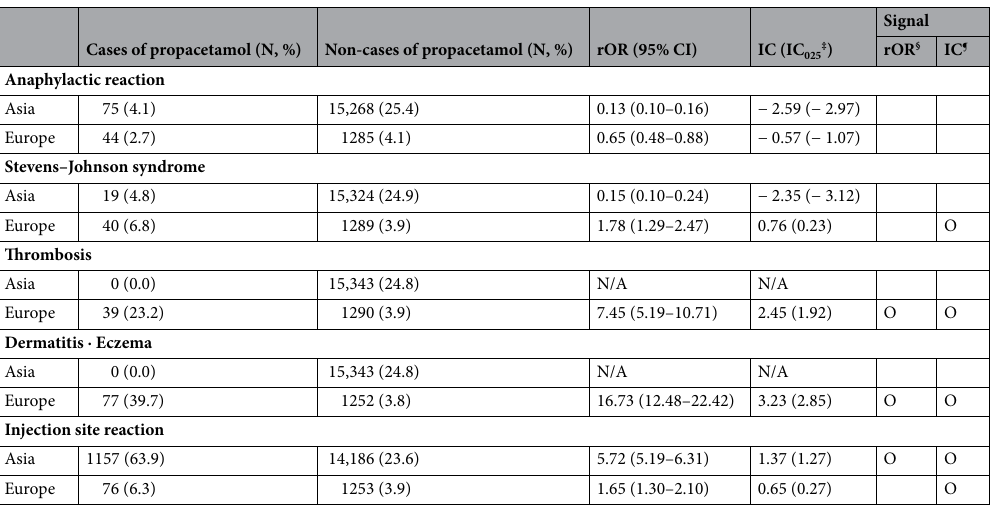
Table 3. Signal detection of propacetamol using disproportionality methods and empirical Bayesian geometric mean in WHO-UMC VigiBase from 1987 to 2020. AE adverse events, rOR reporting odds ratio, CI confidential interval, WHO-UMC World Health Organisation-Uppsala Monitoring Centre, IC information component. † ‘O’ within the column ‘Signal’ denotes that it met the threshold for a signal. ‡ IC 025 is lowest bound of 95% CI for IC. § Safety signal detection with rOR assessed as AEs where thresholds of rOR > 2. ¶ Safety signal detection with IC assessed as AEs where IC 025 >